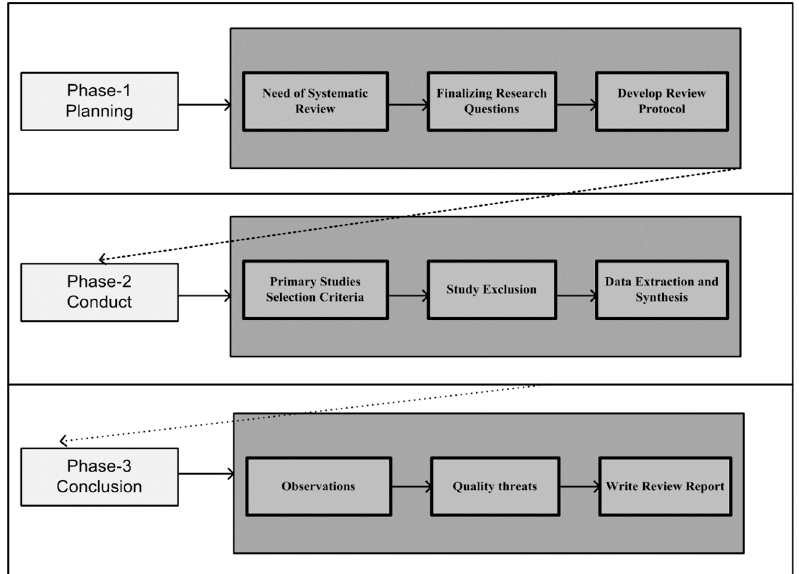
Figure 3. Systematic Literature Review (SLR) protocol.